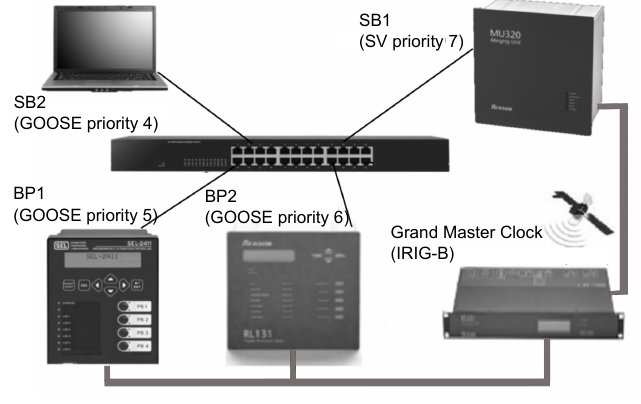
Figure 9. Bay laboratory